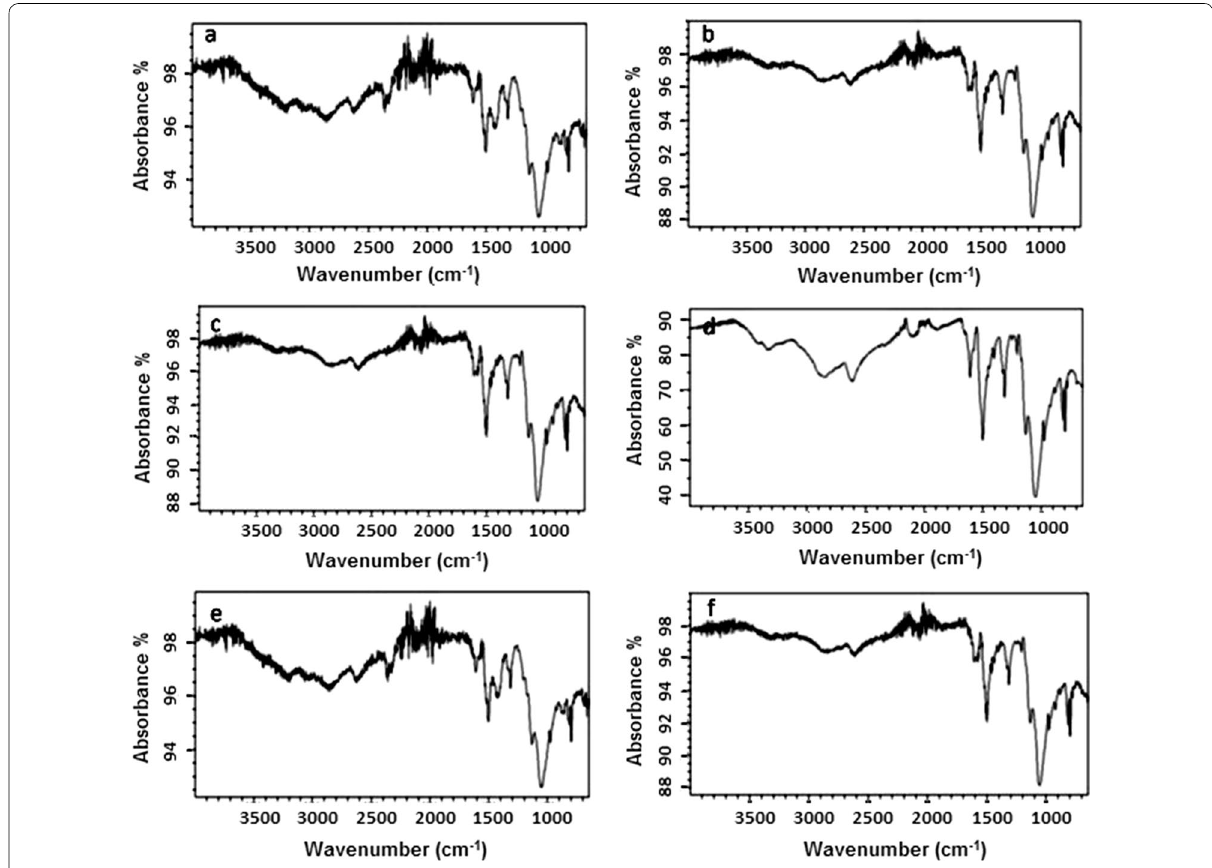
Fig. 2 FTIR spectra of a POC, and POC/Cr NCs containing b 1% Ni NPs, c 3% Ni NPs, d 5% Ni NPs, e 7% Ni NPs, f 10% Ni